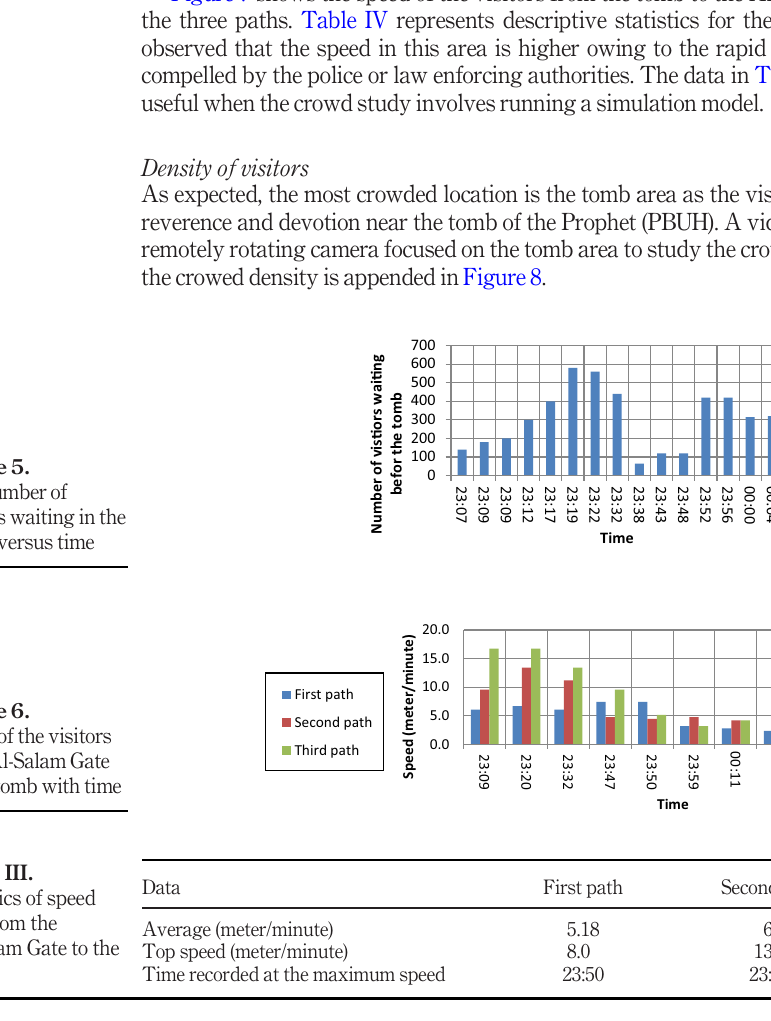
Figure 6. Speed of the visitors from Al-Salam Gate to the tomb with time